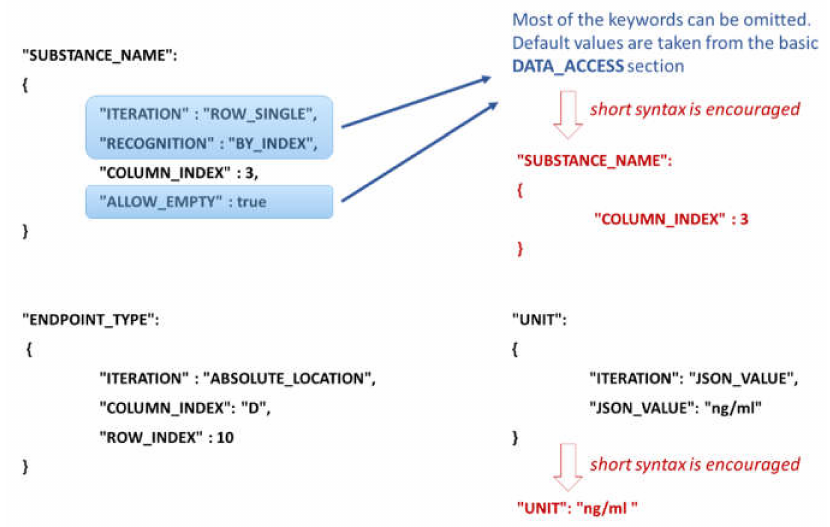
Figure 5. Excel Data Location definition for the attributes SUBSTANCE_NAME, ENDPOINT_TYPE and UNIT for three di ff erent iteration modes and short JSON syntax alternatives as